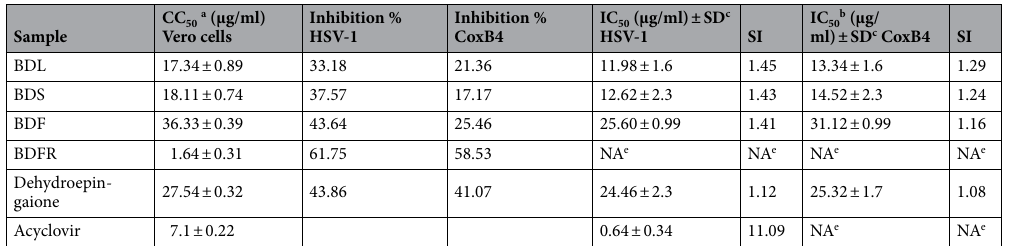
Table 2. Cytotoxicity and antiviral activity of the essential oils of the leaves, stems, flowers and fruits of B. daphnoides and the isolated compound (dehydroepingaione). a Toxic concentration to 50% of the Vero cells. b Concentration required to inhibit 50% of the viral growth . c Standard deviation. d SI, selectivity index (= CC IC 50 ). e Not applicable.